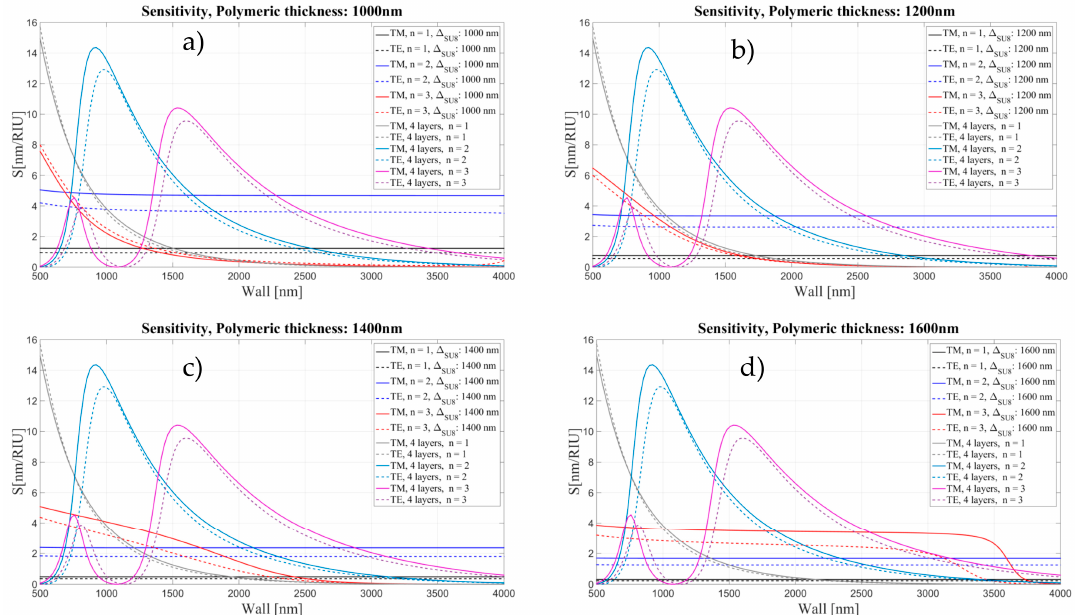
Figure 18. Sensitivity (nm/RIU) for the four- and five-layer models as a function of wall thickness for two different polarizations and three mode orders, corresponding to different thickness of polymeric layer: ( a ) 1000 nm; ( b ) 1200 nm; ( c ) 1400 nm; and ( d ) 1600 nm.